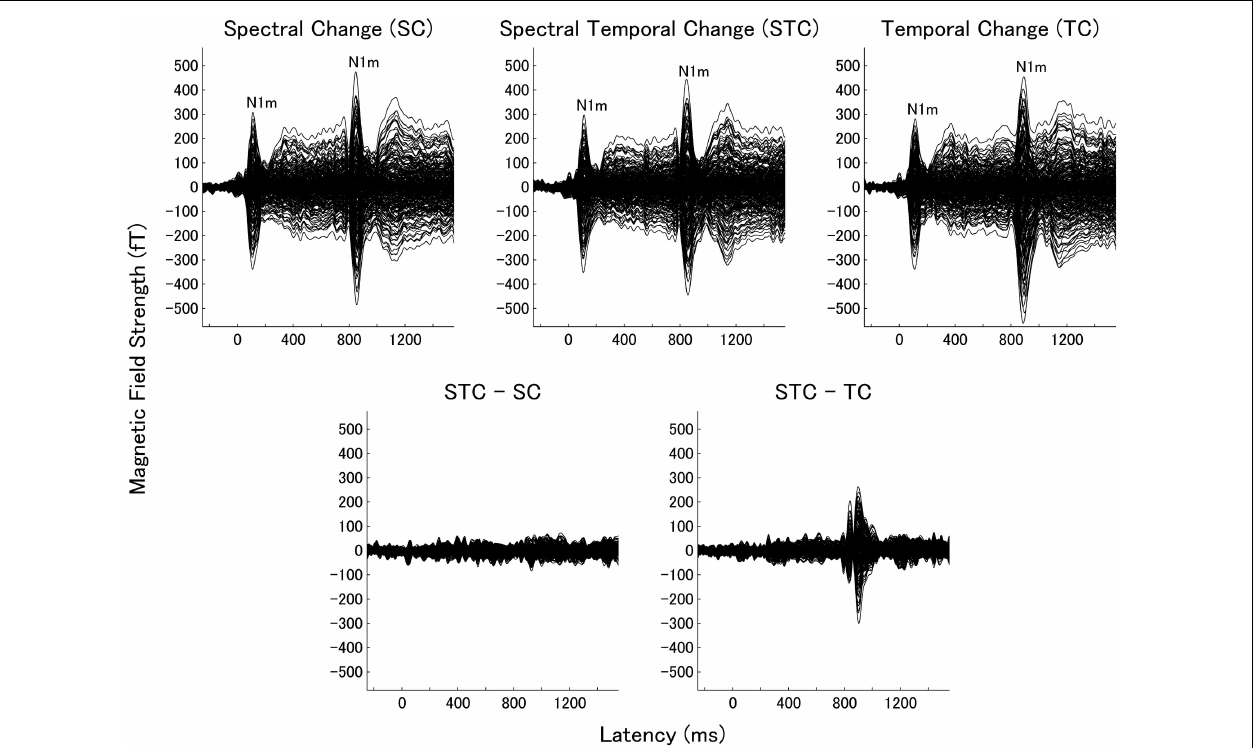
FIGURE 4 | Examples of individual magnetic waveforms of all sensors in experiment 2. The figure displays the auditory evoked fields elicited by the test stimuli (band-pass filtered train pulses). All graphs are arranged according to Figure 3